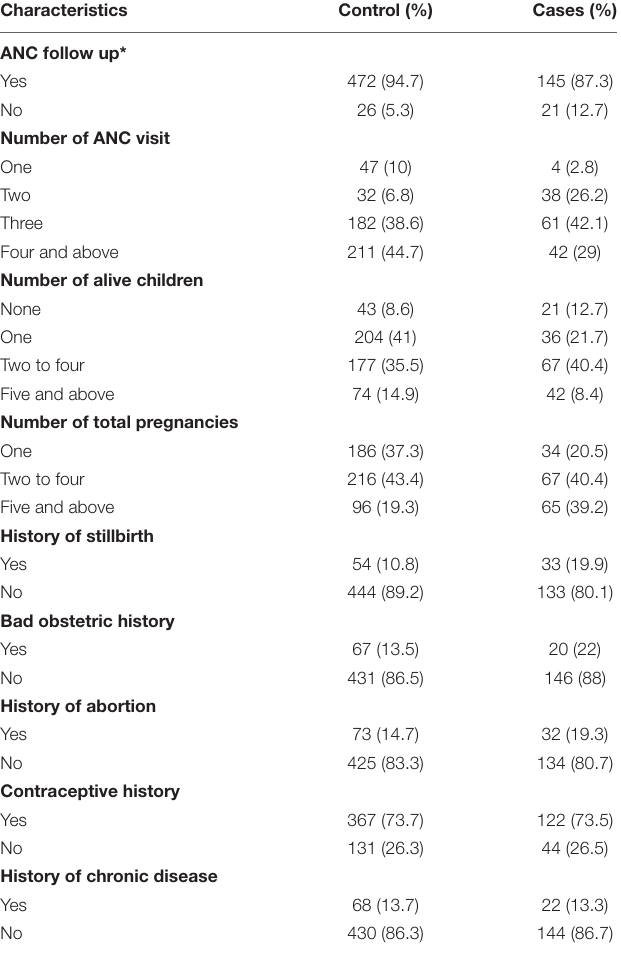
TABLE 3 | Distribution of obstetric characteristics over maternal near-miss in West Shoa zone public hospitals, Central Ethiopia, 2020. Characteristics Control (%)